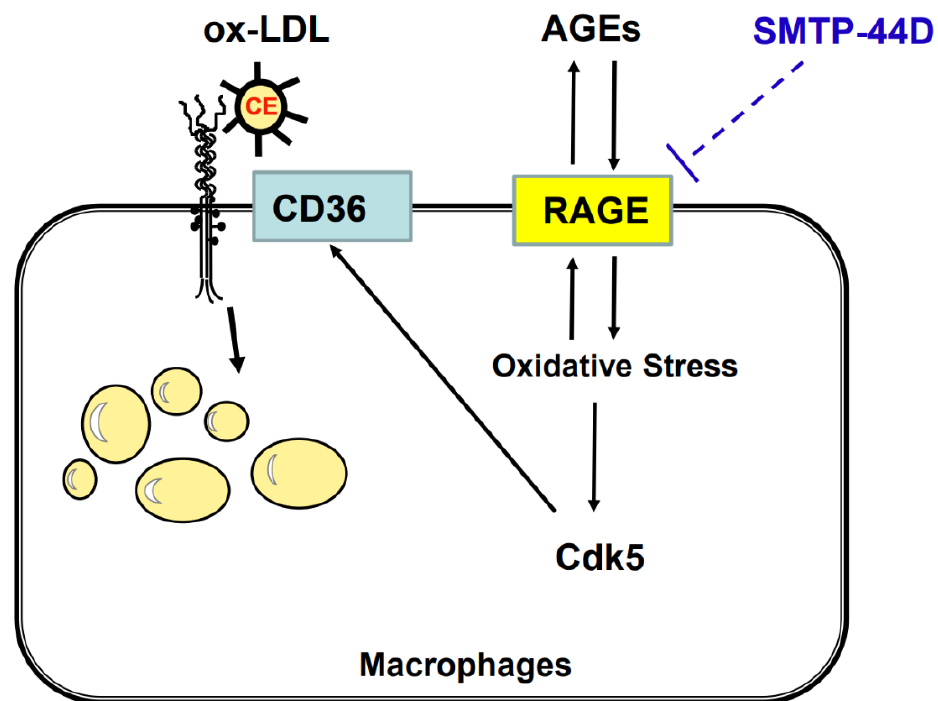
Figure 4. Possible anti-atherosclerotic actions of SMTP-44D. SMTP-44D could inhibit the AGEs- RAGE-induced macrophage foam cell formation through the suppression of the CD36-Cdk5 pathway. AGEs, advanced glycation end products; RAGE, receptor for AGEs; Cdk5, cyclin-dependent kinase 5; ox-LDL, oxidized low-density lipoprotein.